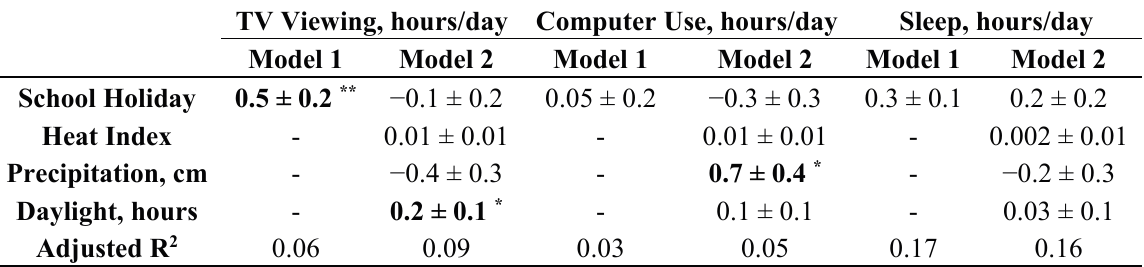
Table 3. Results of multivariable regression examining associations of school holiday with lifestyle habits over the prior 30